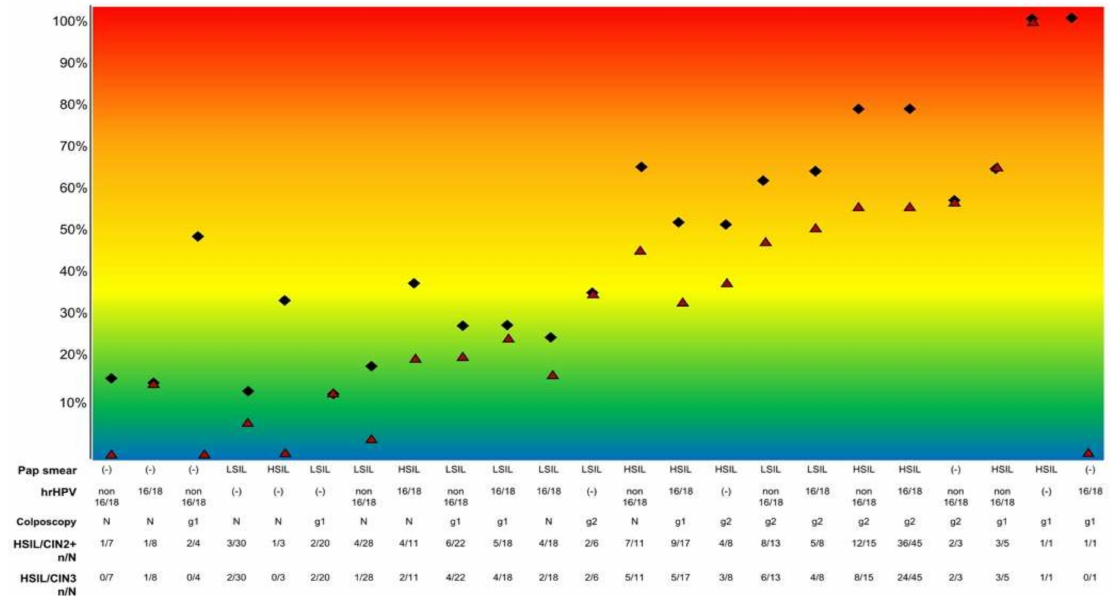
Figure 2. Prevalence of HSIL/CIN2+ (black diamonds) and HSIL/CIN3 (red triangles) according to the Pap test result, hrHPV testing and genotyping, and colposcopic impression considering the 231 women in whom the presence or absence of grade 2 colposcopy lesions could be confidently excluded or confirmed (all women with a type 1 or 2 transformation zone and women with a type 3 transformation zone with grade 2 findings). No women showed a negative Pap test with HPV 16/18 infection or grade 2 findings at the colposcopy evaluation. Footnote: ( − ): negative; LSIL: low-grade squamous intraepithelial neoplasia (including atypical squamous cell of undetermined significance (ASC-US)); HSIL: high- grade squamous intraepithelial neoplasia; hrHPV: high-risk human papillomavirus; HSIL/CIN2+: high-grade squamous intraepithelial lesion/grade 2 or 3 cervical intraepithelial neoplasia or adenocarcinoma in situ. HSIL/CIN3: high-grade squamous intraepithelial lesion/grade 3 cervical intraepithelial neoplasia or adenocarcinoma in situ. N: normal colposcopy; g1: grade 1 findings; g2: grade 2